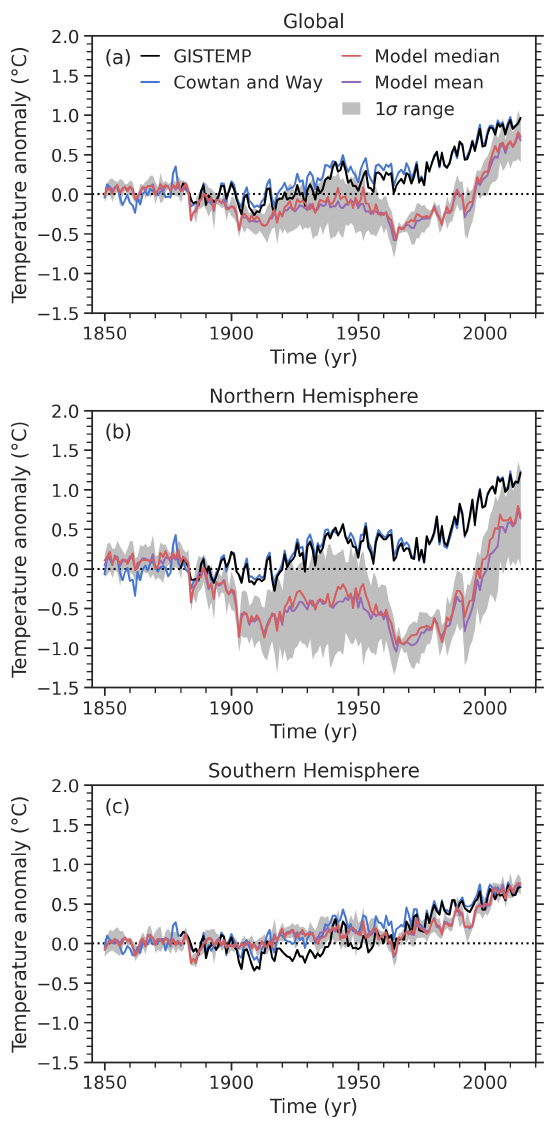
Figure 6. The median, mean, and 1 standard deviation range of the annual mean surface air temperature (SAT) anomalies from the four realizations of the CMIP6 historical simulation compared with reconstructed surface temperature anomalies from GISTEMP ver- sion 4 and HadCRUT4 infilled by kriging (Cowtan and Way version 2.0). The anomalies are defined with respect to the 1850–1900 pe- riod (1880–1900 for GISTEMP). Panels (a) , (b) , and (c) show the global, Northern Hemisphere, and Southern Hemisphere means, re-